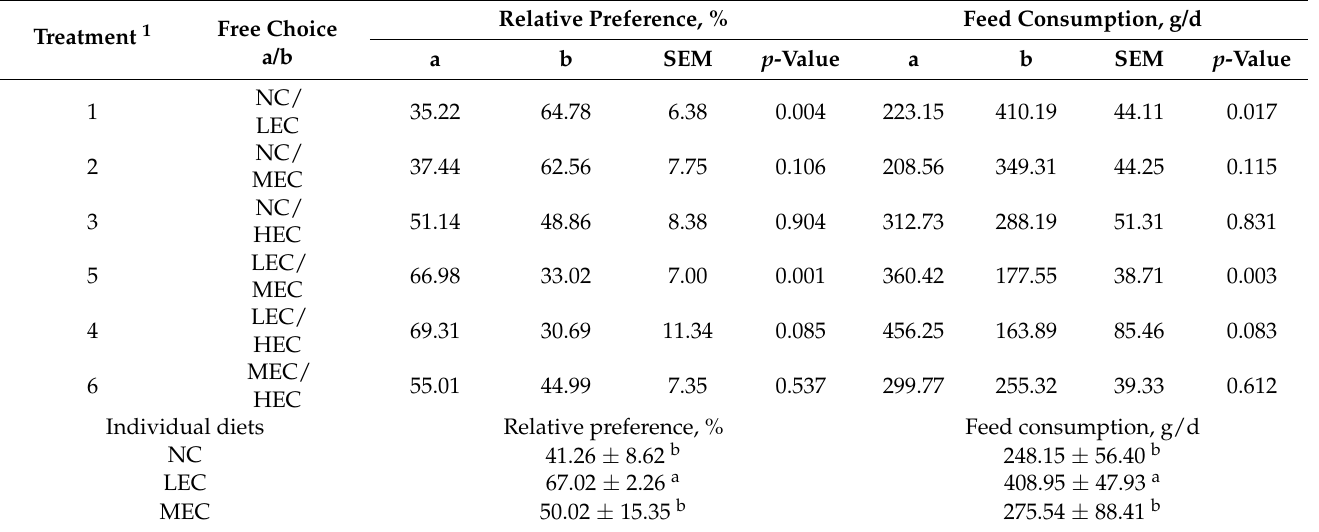
Table 3. Feed consumption and relative preferences of piglets offered different gelatinization degrees of extruded corn in experiment